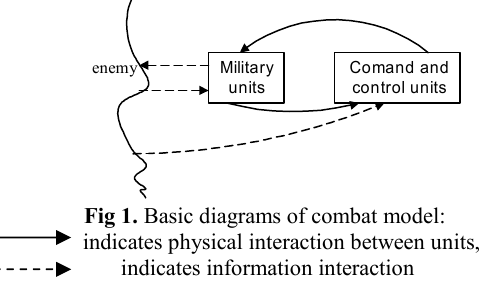
Fig 1. Basic diagrams of combat model: indicates physical interaction between units, indicates information